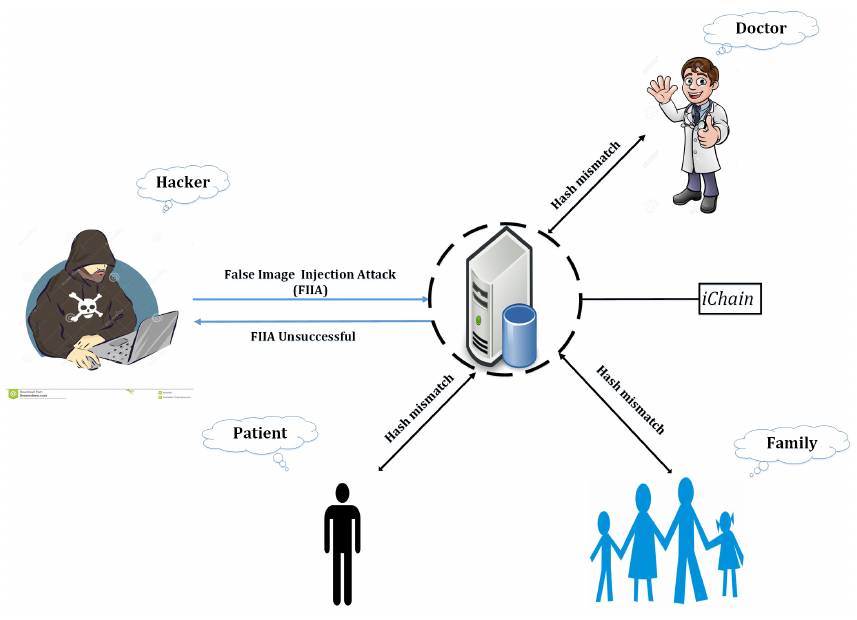
Figure 5. Conceptual framework of i Chain .